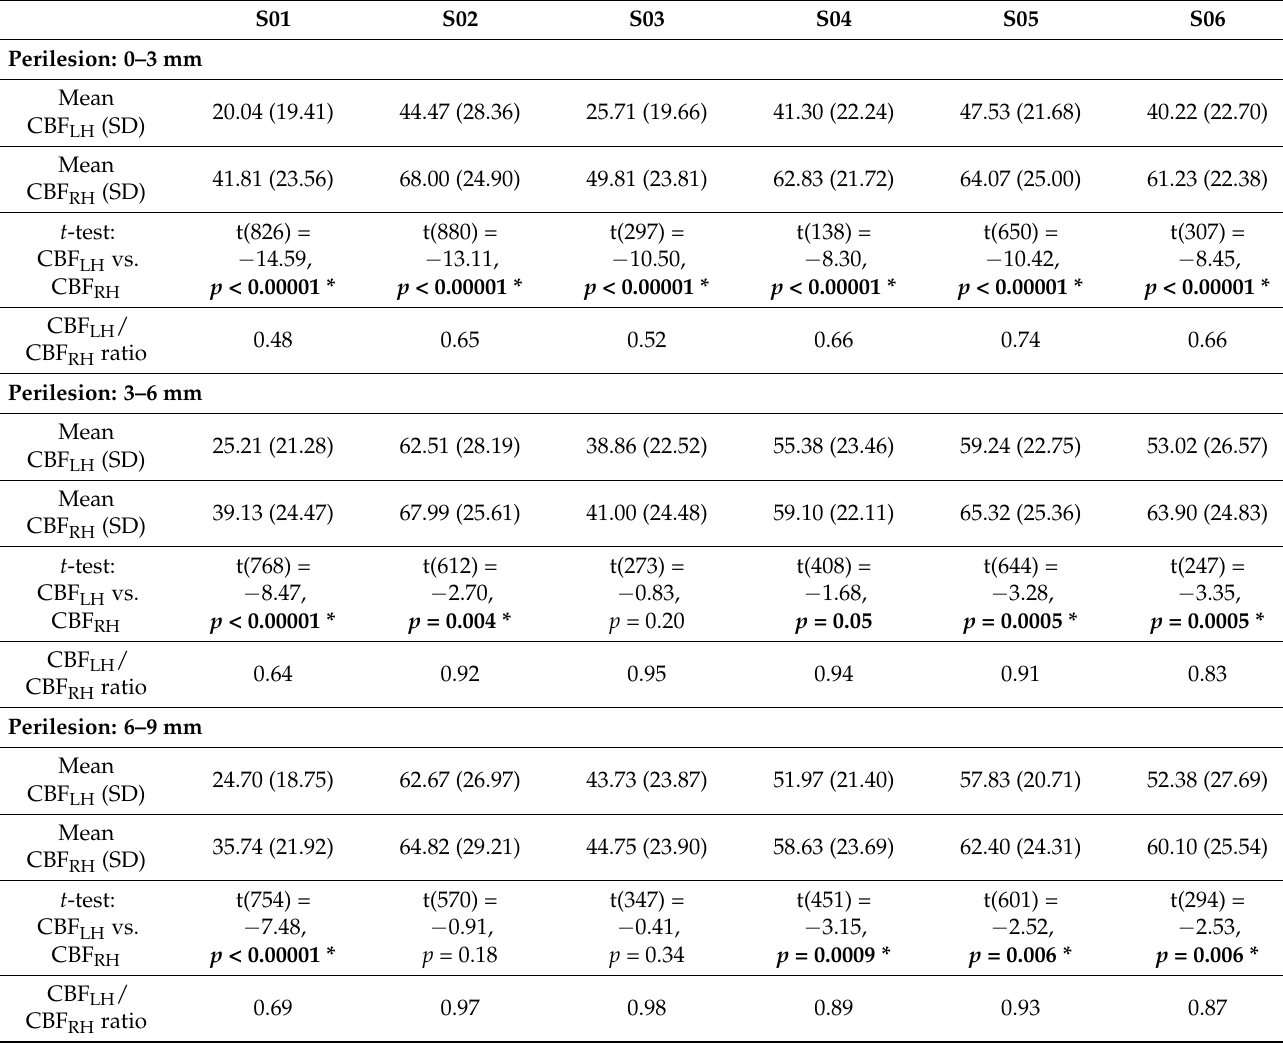
Table A1. Mean CBF (mL/100 g tissue/min) values in the four left hemisphere (CBF LH ) and four right hemisphere (CBF RH ) perilesional bands. Paired t-test results are given for CBF LH versus CBF RH differences. A perfusion ratio was calculated by dividing CBF LH by CBF RH to demonstrate the extent of differences within perilesional bands between the two hemispheres. Values < 1 indicate lower CBF LH , and values > 1 indicate greater CBF LH . Bold values indicate that there was a significant difference in CBF values between the two hemispheres at p < 0.05. * indicates that the p -value survived Bonferroni correction at p <